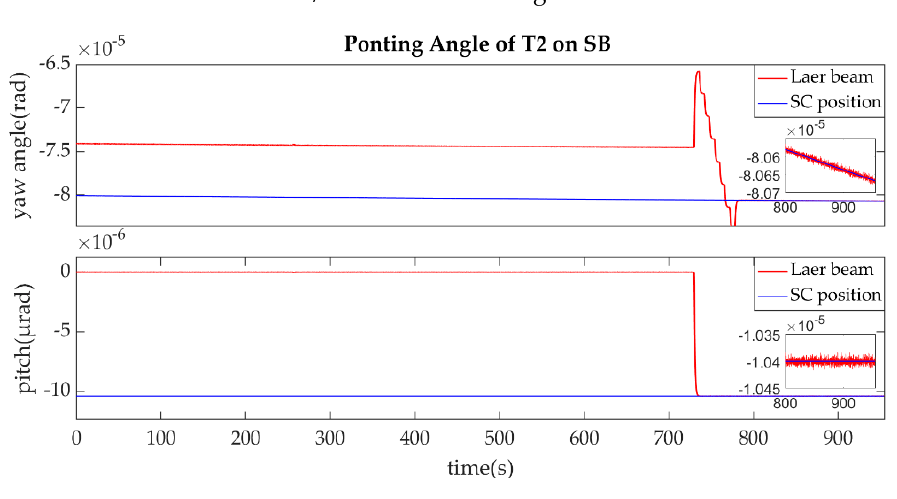
Figure 19. Ponting Angle of T2 on SB.